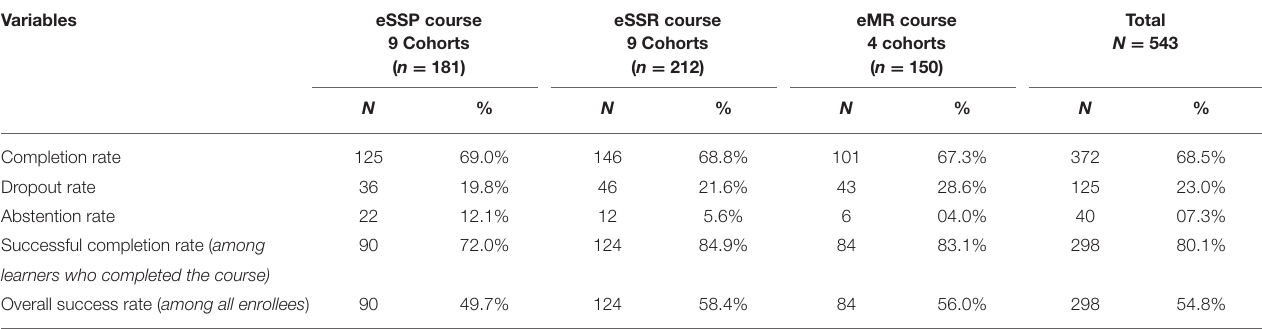
TABLE 3 | Results of learners on the blended courses in Primary Health Care (eSSP), Management of Sexual and Reproductive Health Services (eSSR), and Research methods (eMR), Guinea, 2018–21. Variables